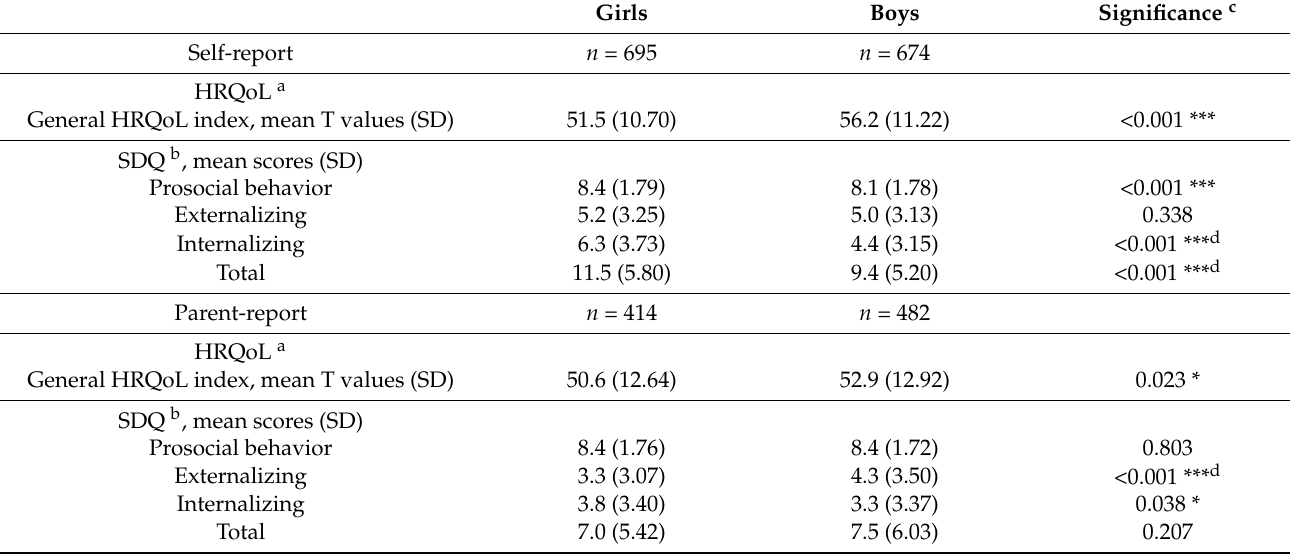
Table 3. Self- and parent-reported HRQoL and psychological symptoms in boys and